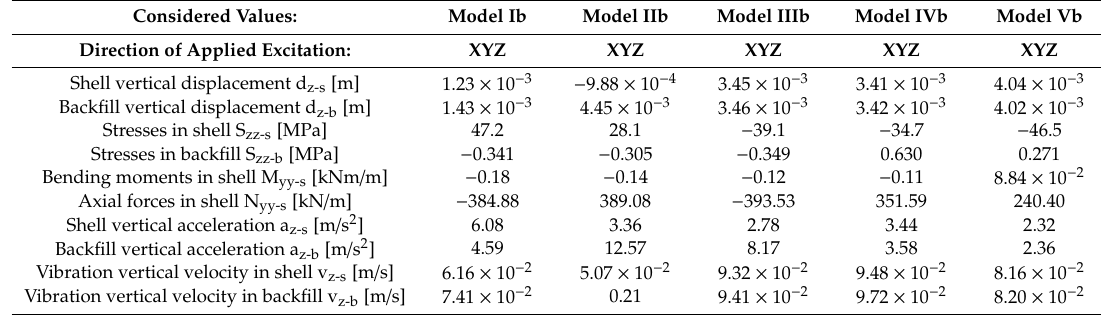
Table 2. The results of the numerical analyses of the soil–steel bridge with and without the EPS, under seismic excitation (El Centro earthquake) simultaneously in three directions